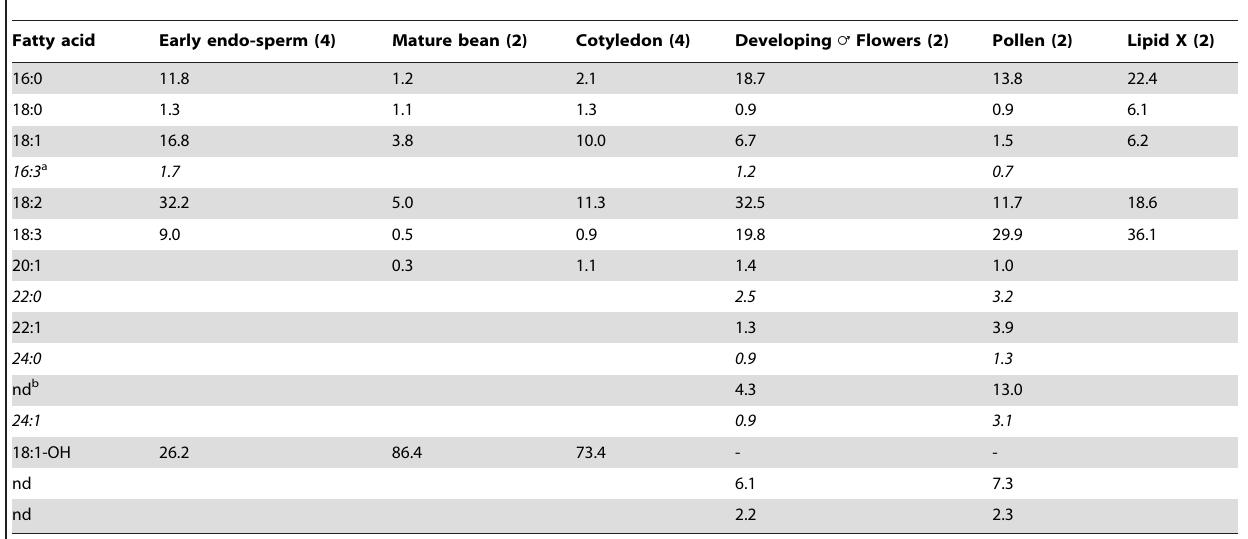
Table 2. Fatty acid analysis of castor tissues and purified lipid X.